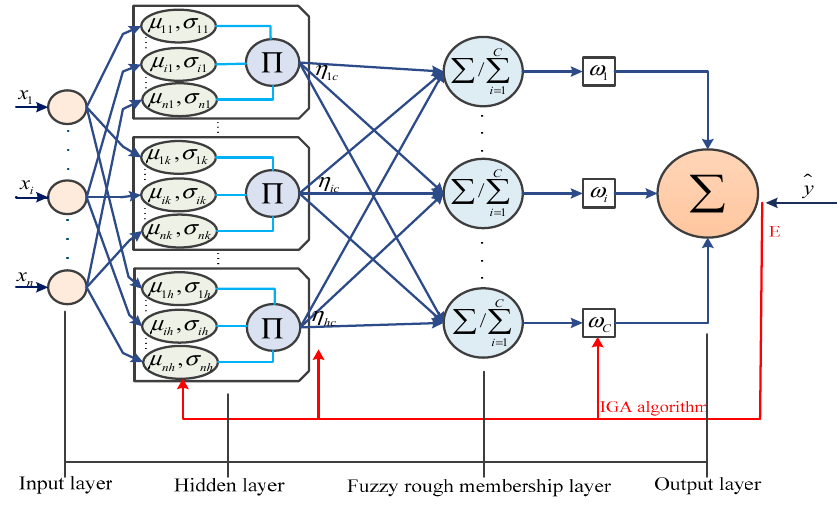
Figure 3. Topology of the multiple input-single output FRRBFNN model. The input layer is to import external data into the network, that is, each neuron in layer represents an input variable x i . Each neuron in this layer represents the corresponding shearer drum characteristic parameter c i after attribute reduction.